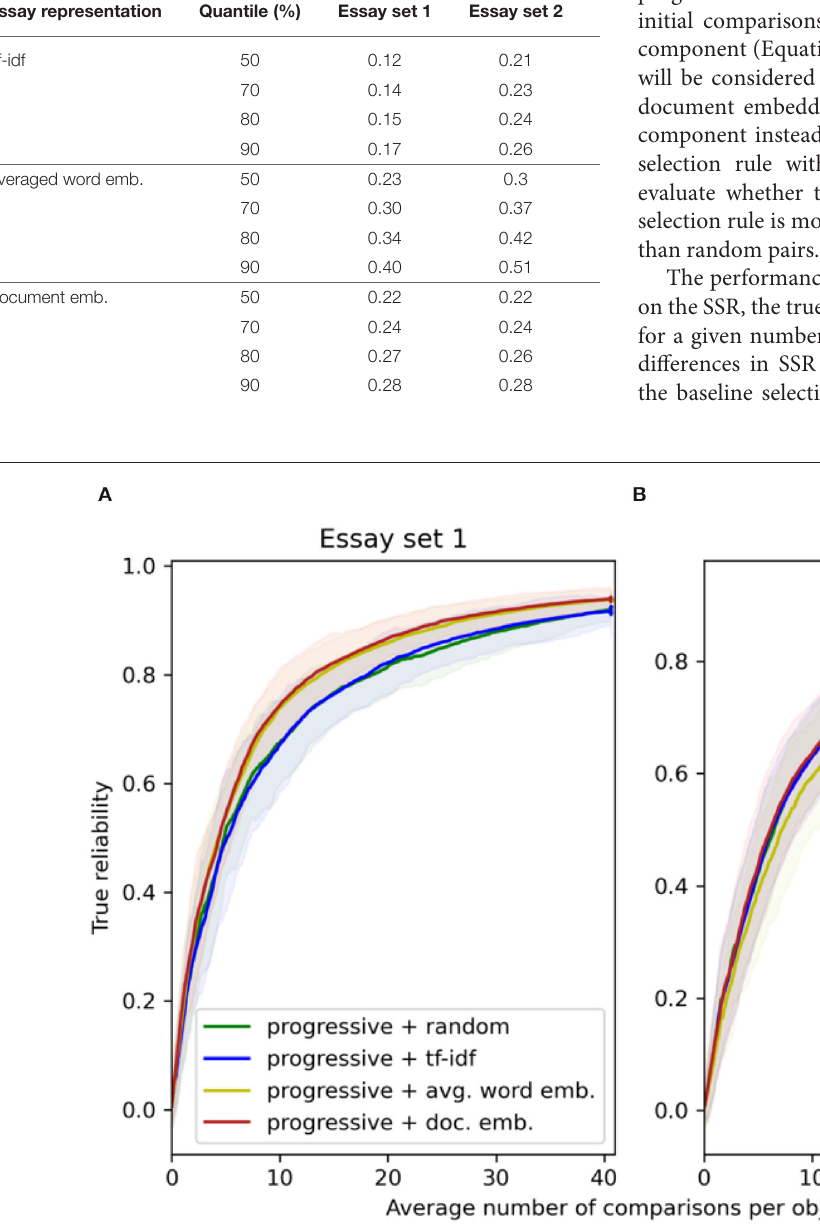
FIGURE 1 | For essay set 1 ( A , N 1 = 141) and 2 ( B , N 2 = 150), the true reliability resulting from the progressive selection with a random component, and a similarity component using tf-idf, averaged word embeddings and document embeddings (100 simulations). The solid lines indicate the mean values and the transparent bands indicate the 95% point-wise confidence